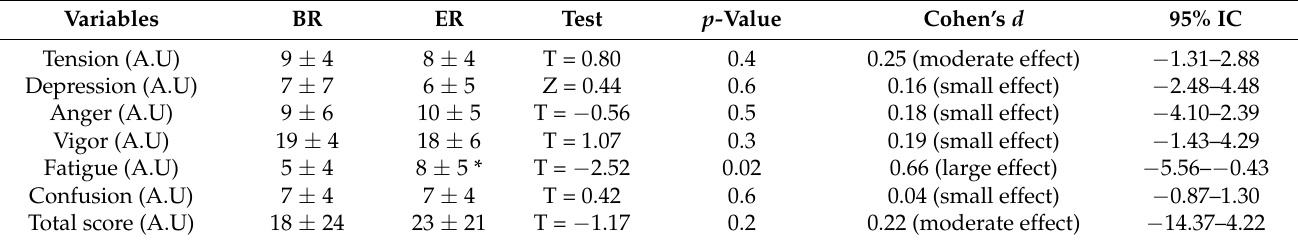
Table 1. The results of the Profile of Mood States recorded before (BR) and at the end of Ramadan (ER).